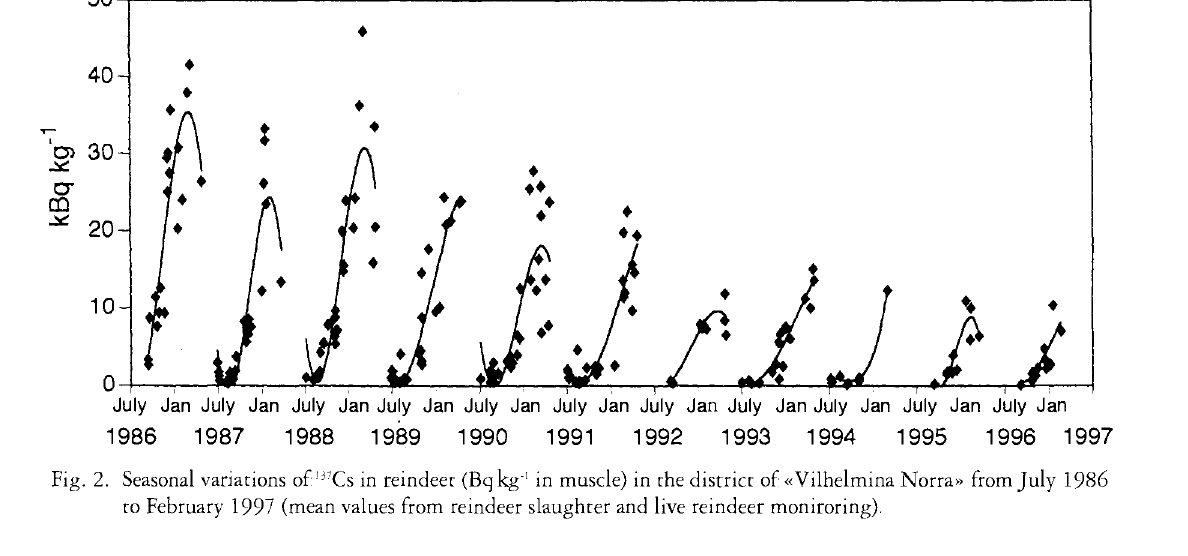
Fig. 2. Seasonal variations of 1 i7 Cs in reindeet (Bq kg 1 in muscle) in the district of «Vilhelmina Norra» from July 1986 to February 1997 (mean values from reindeer slaughter and live reindeer